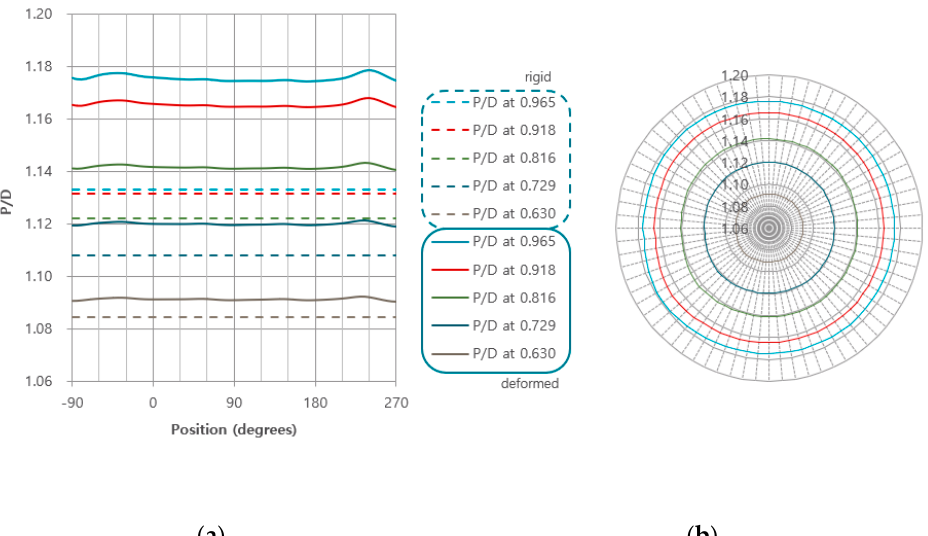
Figure 8. Pitch distribution changes of model 1 in the non-cavitating flow: ( a ) pitch distribution change according to the blade position, ( b ) radial chart of pitch distribution of composite propeller.